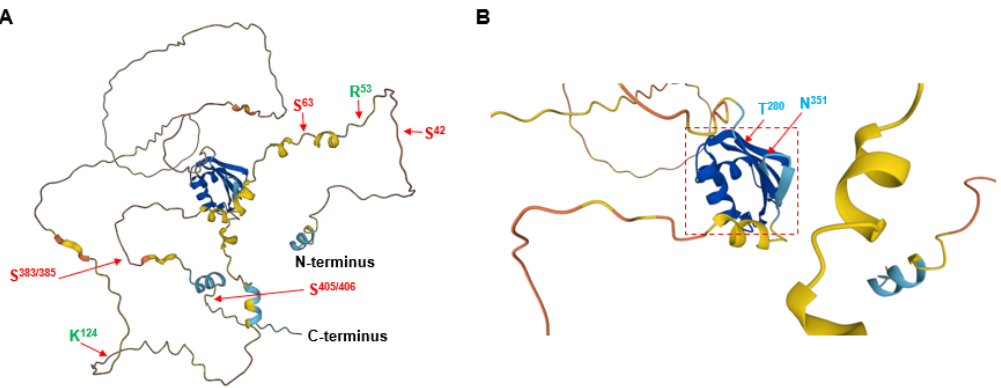
Figure 2. Predicted three-dimensional (3D) structure of human POLDIP3 using the AlphaFold Protein Structure Database (https://alphafold.ebi.ac.uk/, accessed on October 19, 2022). ( A ) The 3D structure of the full-length protein of human POLDIP3. ( B ) The 3D structure of the RRM domain of human POLDIP3 is highlighted with a dashed red square. The two residues flanking the five APIM motifs, arginine-53 and lysine-124, are shown in GREEN colored fonts. The two residues flanking the RRM domain, threonine-280 and asparagine-351 are shown in BLUE colored fonts. The serine residues (serine-42, -63, -383/385, and -405/406) that can be phosphorylated are shown in RED colored fonts.